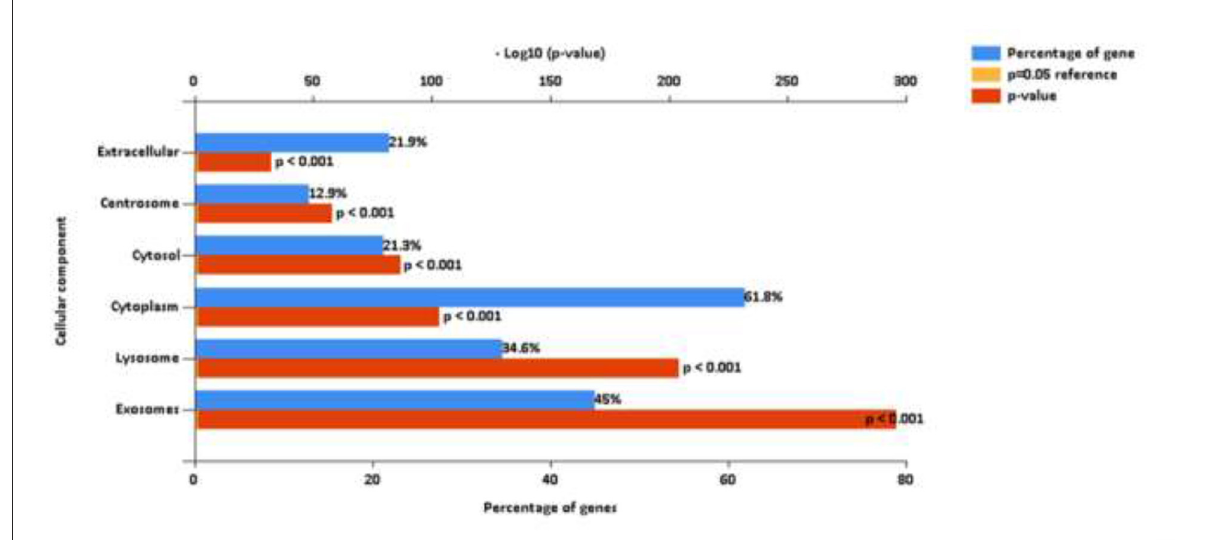
FIGURE4 FunRich analysis output, after mapping 2,047 proteins to GO Cellular Component terms. These proteins were identified from a pooled sample of equine synovial fluid (11ml) used to generate the SF-EV spectral library for this study. SF was sourced from healthy, OA and OA + MSC treated joints in order to encapsulate all potential proteins that may be present across all experimental groups.